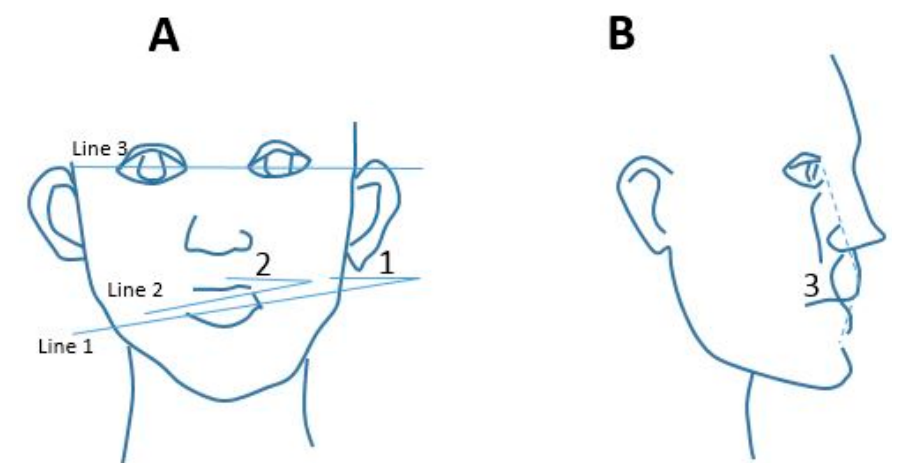
Figure 3. Construction of feature points and lines ( A ) 1, Angle between line 1 (connecting the bilateral mandibular angles) and line 3 (connecting the bilateral eyespots); 2, angle between line 2 (connecting the bilateral oral angles) and line 3; ( B ) 3, angle formed with lines connecting the eyespot point, upper lip point, and soft tissue B-point [15].